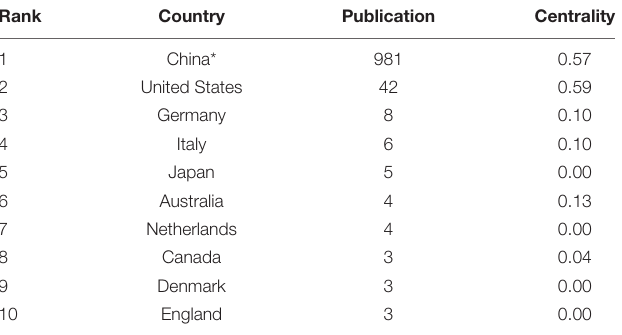
TABLE 3 | The top 10 countries ranked by number of